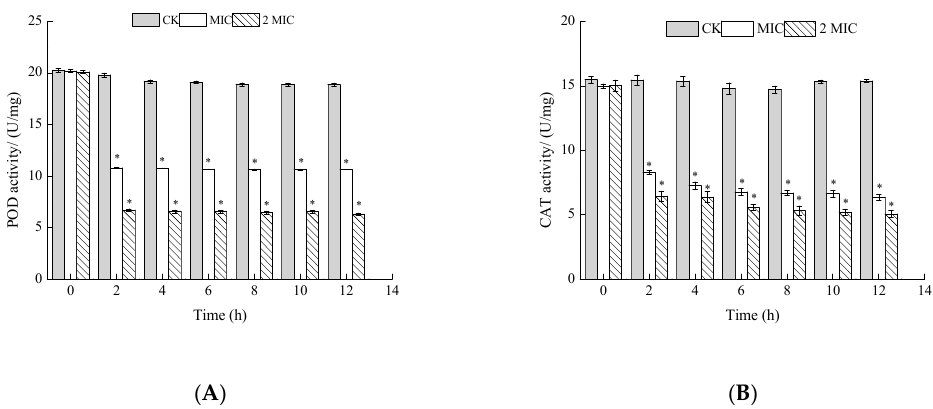
Figure 6. Effects of ε -PL on peroxidase (POD) ( A ) and catalase (CAT) ( B ) activity of S. putrefaciens. Bars represent the standard error of the means. The superscript (*) indicates a result that is significantly different to the equivalent control point (t test, p < 0.05 ).